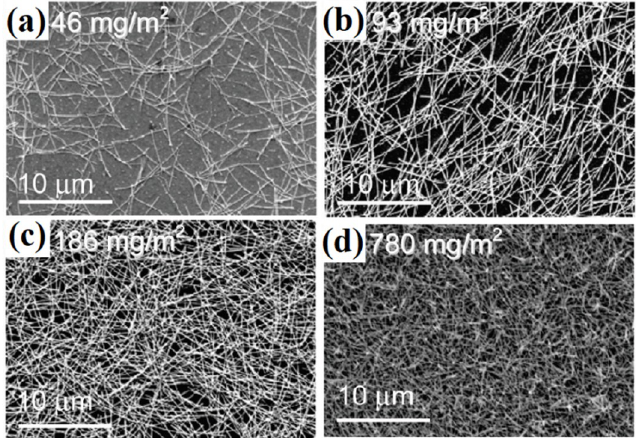
Figure 6. SEM images of the Ag (nanowire) NW thin film with different thicknesses shows increasing the film uniformity by increasing the film thickness. Different thicknesses are realized by varying different deposited mass per unit area: ( a ) 46 mg/m 2 , ( b ) 93 mg/m 2 , ( c ) 186 mg/m 2 , and ( d ) 780 mg/m 2 . Reproduced with permission from [16]. Copyright 2009 ACS Publishing.